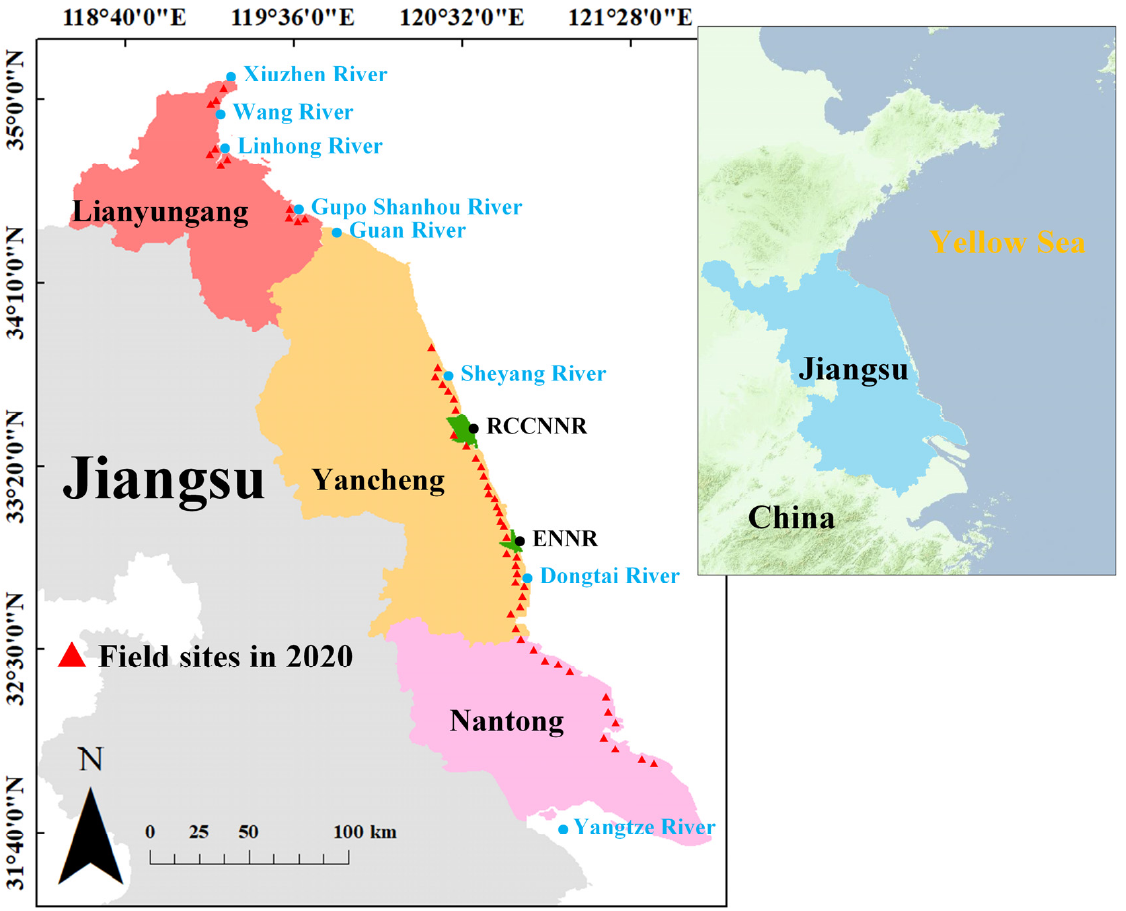
Figure 1. Coastline of the three major cities in Jiangsu Province: Lianyungang, Yancheng, and Nantong. The red triangles are the site of field investigation. The green areas are the Yancheng National Nature Reserve.